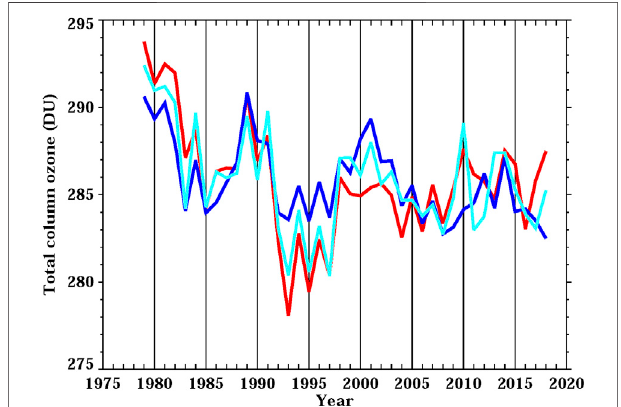
FIGURE 7 | Evolution of near-global TCO obtained from the MSR2 data (red line) and retrieved from proxies without (blue line) and with Arosa/Davos TCO as an additional proxy (light blue line). The correlation coef fi cients are 0.68 and 0.89 for the cases without and with Arosa/Davos TCO.